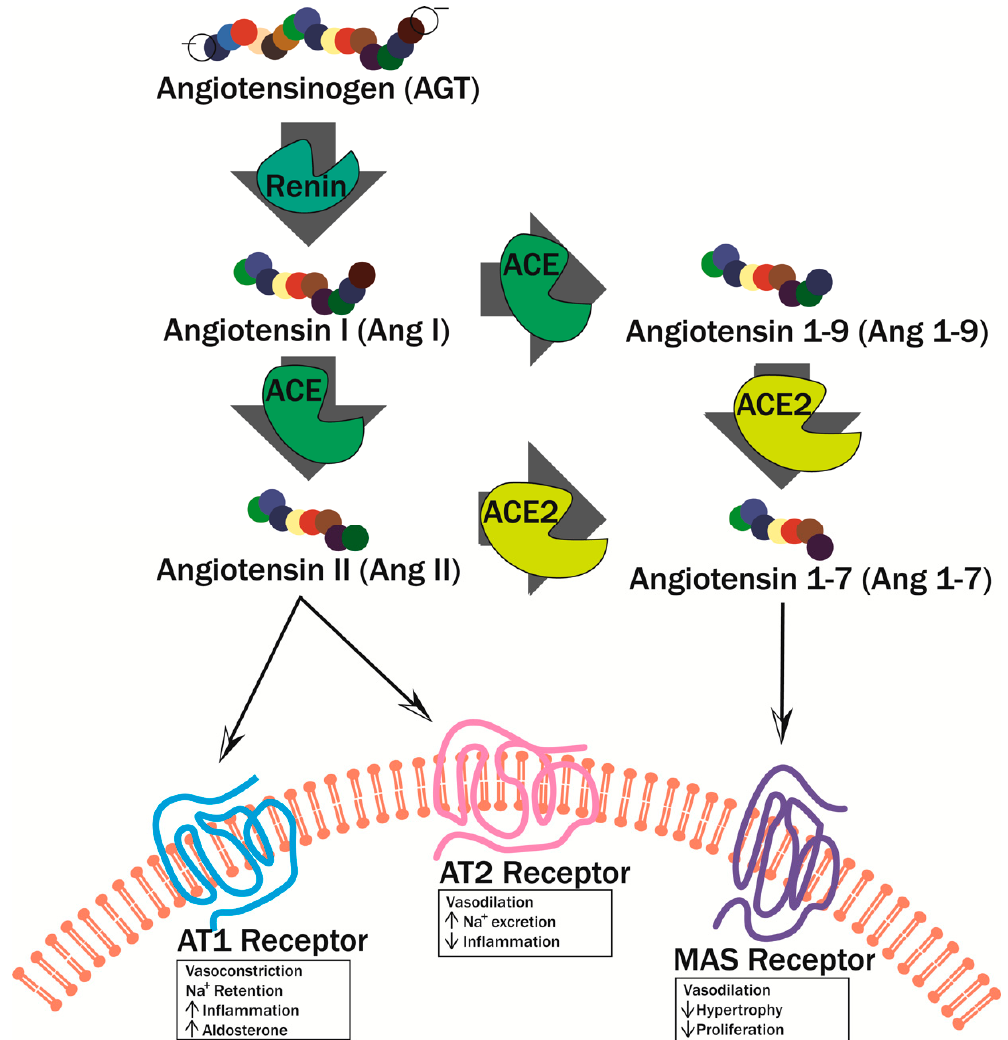
Figure 5. Renin–angiotensin pathway. Angiotensin is cleaved by renin to form Ang I. Ang I is cleaved by angiotensin- converting enzyme (ACE) into either Ang II or angiotensin 1–9 (Ang 1–9). Ang II can bind two different receptors: AT1 Receptor and AT2 Receptor. When Ang II binds AT1R, it initiates vasoconstriction, sodium retention, increased inflammation, and increased aldosterone. When Ang II binds AT2R, then vasodilation, sodium excretion, and decreased inflammation occur. Ang II and Ang 1–9 are also converted to Ang 1–7 by ACE2. Ang 1–7 binds the MAS1 oncogene (MAS) receptor where it triggers vasodilation and decreases hypertrophy and